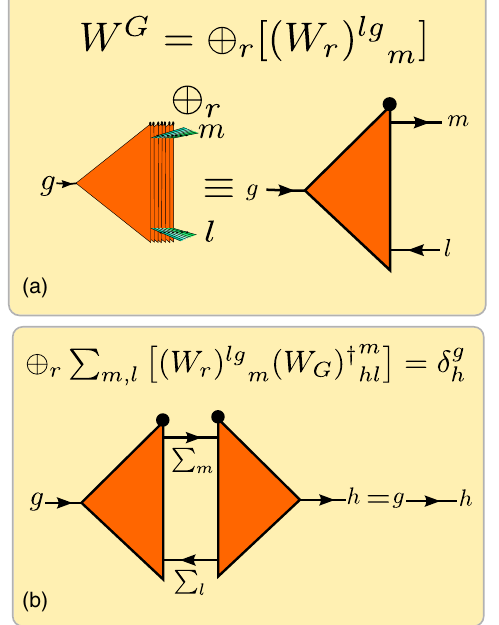
FIG. 4. (a) The direct sum of W is a unitary tensor. It allows us r to change basis from C ð G Þ to the direct sum of all the irreps times ⊗ V V their conjugate ⊕ ¯ r Þ . On the upper part of the figure, we r ð r ’ s. A simplified picture explicitly draw the collection of all the W r is shown on the lower part, where the direct sum is implicit in the absence of the label r attached to the legs of the tensor. We will use this notation in the following. When we want to represent W , r we will attach r to the leg, while we represent W by exactly the G same drawing but without the r . From now on, for simplicity, we will also omit to label the legs with letters. (b) The unitarity of W G is encoded in the fact that the contraction over the two legs acting ⊗ V C ð G Þ . on ⊕ ð V ¯ r Þ gives a delta function in r